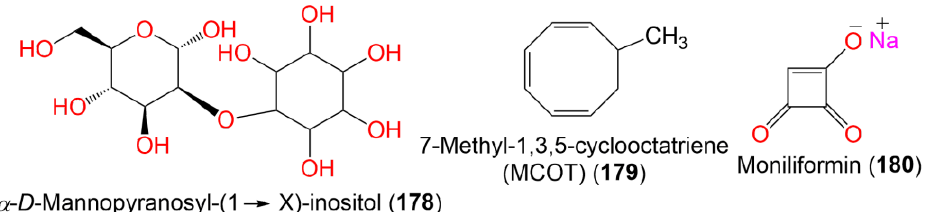
Figure 18. Structures of fatty acids ( 173 – 175 ) and sugar derivatives (176 – 180 ) isolated from F. ox- ysporum